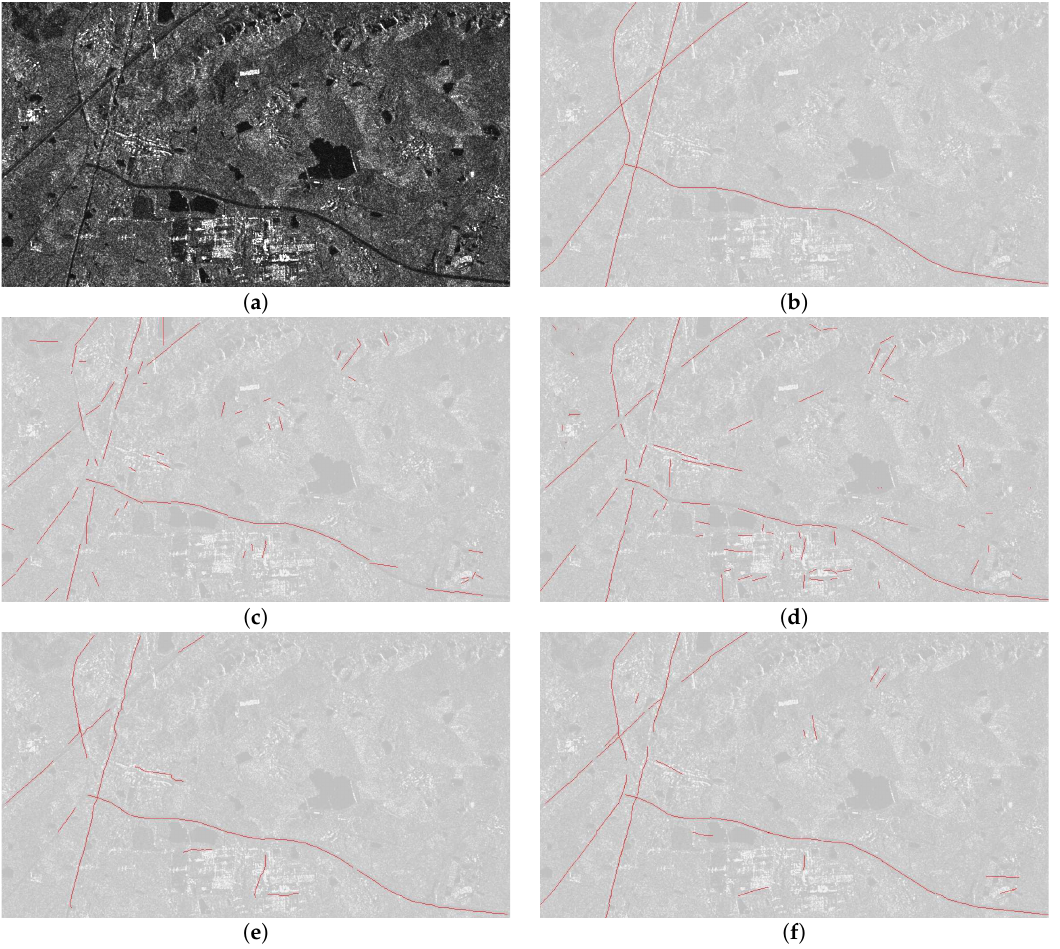
Figure 6. The experimental results on the TerraSAR image from Wuhan, China. ( a ) The original image; ( b ) ground truth; ( c ) results of MLFD; ( d ) results of beamlet; ( e ) results of MRF [8]; ( f ) fusion results of